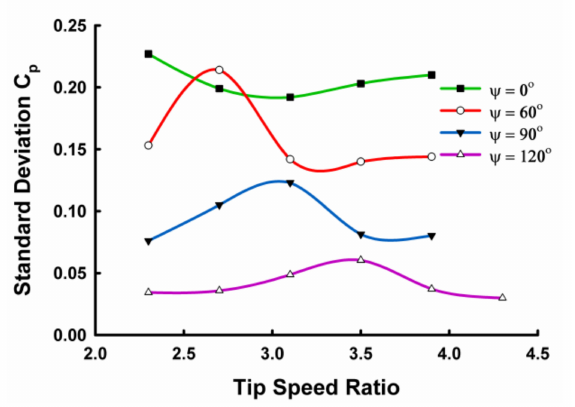
Figure 14. The standard deviation of C p of different helical-bladed and straight-bladed VAWT operating at different